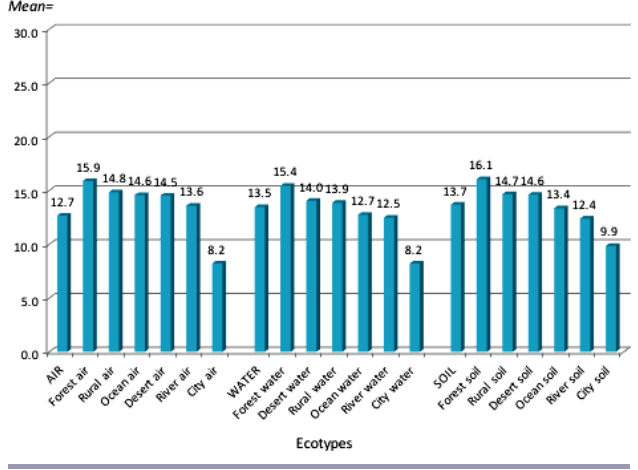
Fig. 2 . Average perceived resilience score across ecotypes. Air, water, and soil of forested systems are perceived as significantly more resilient than are the same media in all other ecotypes. Ocean bed soil, river bed soil, and city soil are also perceived as less resilient than forest soil. A similar pattern is again true for air across ecotypes.